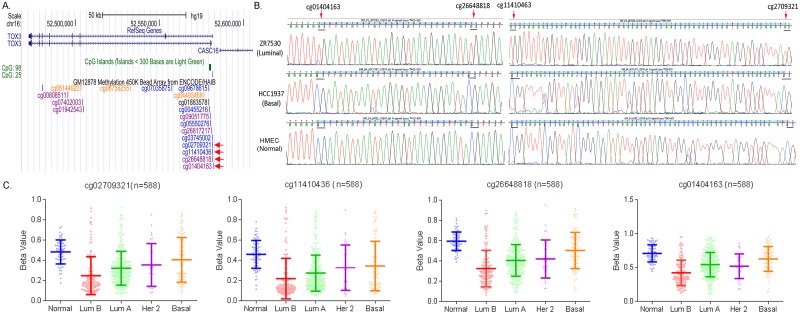
Subtype-specific methylation of the TOX3 promoter in breast tumors.(A) UCSC genome browser shows location of CpG islands in the TOX3 promoter at chromosome 16q12. Four CpG dinucleotides analyzed are indicated with red arrows. (B) Representative chromatographs in the TOX3 promoter after bisulfite treatment revealed unmethylated cytosines in the TOX3 promoter of ZR-75-30 (luminal subtype cells). DNA sequencing was performed on the reverse strand and four unmethylated CpG sites are underlined (AC, reverse complement of TG). In contrast, methylated cytosines (GC, reverse complement of CG) were detected in the promoter of HCC-1937 (basal-like subtype cells) and HMEC (primary epithelial normal cells) because methylation prohibited the effect of bisulfite treatment. (C) Methylation levels of four CpG dinucleotides in the promoter region of TOX3 were analyzed using the TCGA HumanMethylation450 Array data. One-way ANOVA and Tukey’s multiple comparison tests showed a significant difference in methylation levels of the CpG sites between normal breast tissues and luminal A or B breast tumors (p<0.0001) and between basal-like and luminal A or B breast tumors (p<0.01).